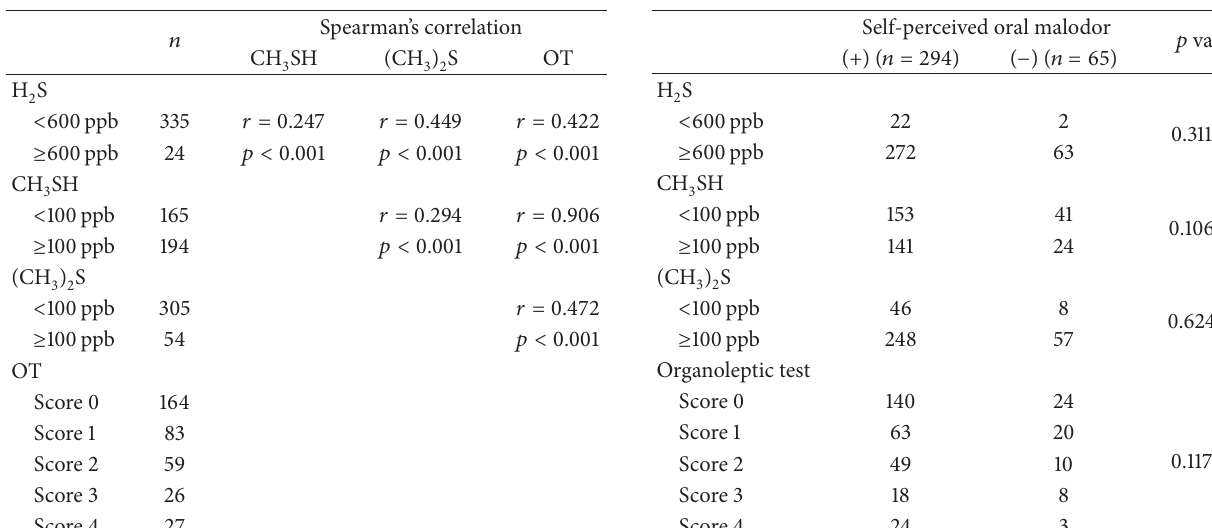
Table 1: Correlation coefficients between the results of 4 parameters regarding oral malodor.